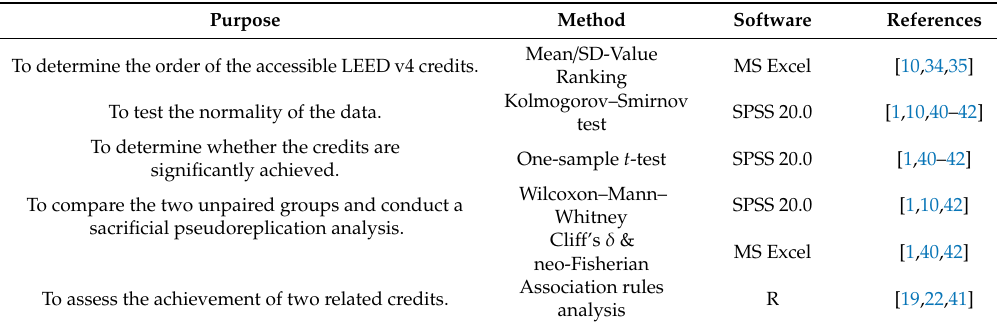
Table 1. The analytical methods used in the